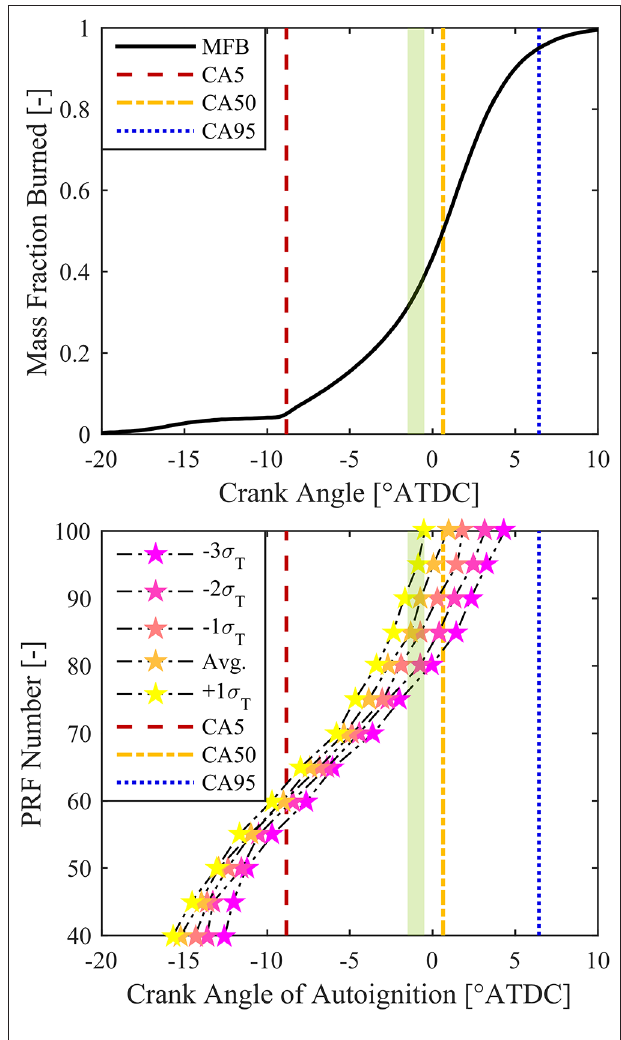
FIGURE 3 | Graphical representation of the binning process by which autoignition zones for various PRF numbers and temperature paths were compared to the mass-fraction burned profile. The green region represents an example 1.0 ◦ CA wide